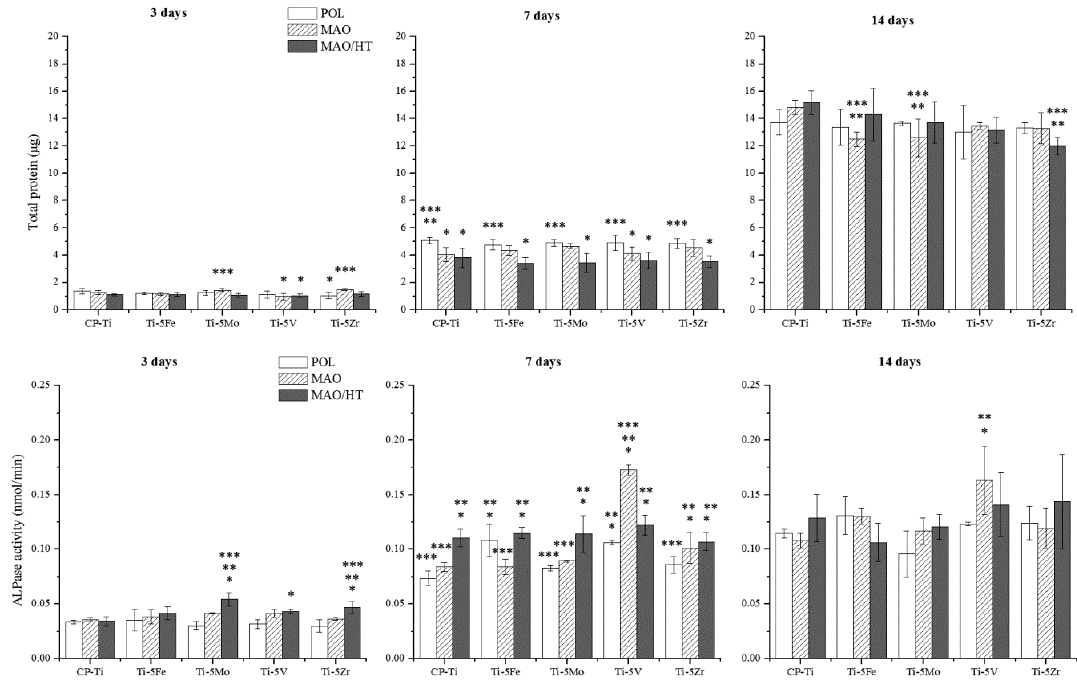
Figure 11. Total protein and ALPase activity in POL ‐ , MAO ‐ , and MAO/HT ‐ treated samples. The experiment was repeated three times and the results are presented as mean ± SD ( * p < 0.05 when compared with cp ‐ Ti(POL), ** p < 0.05 when compared with cp ‐ Ti(MAO), *** p < 0.05 when compared with cp ‐ Ti(MAO/HT)).